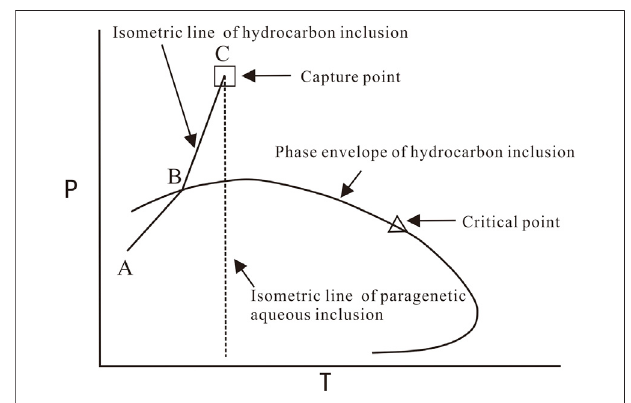
FIGURE 1 | Schematic diagram of PVTx thermodynamic